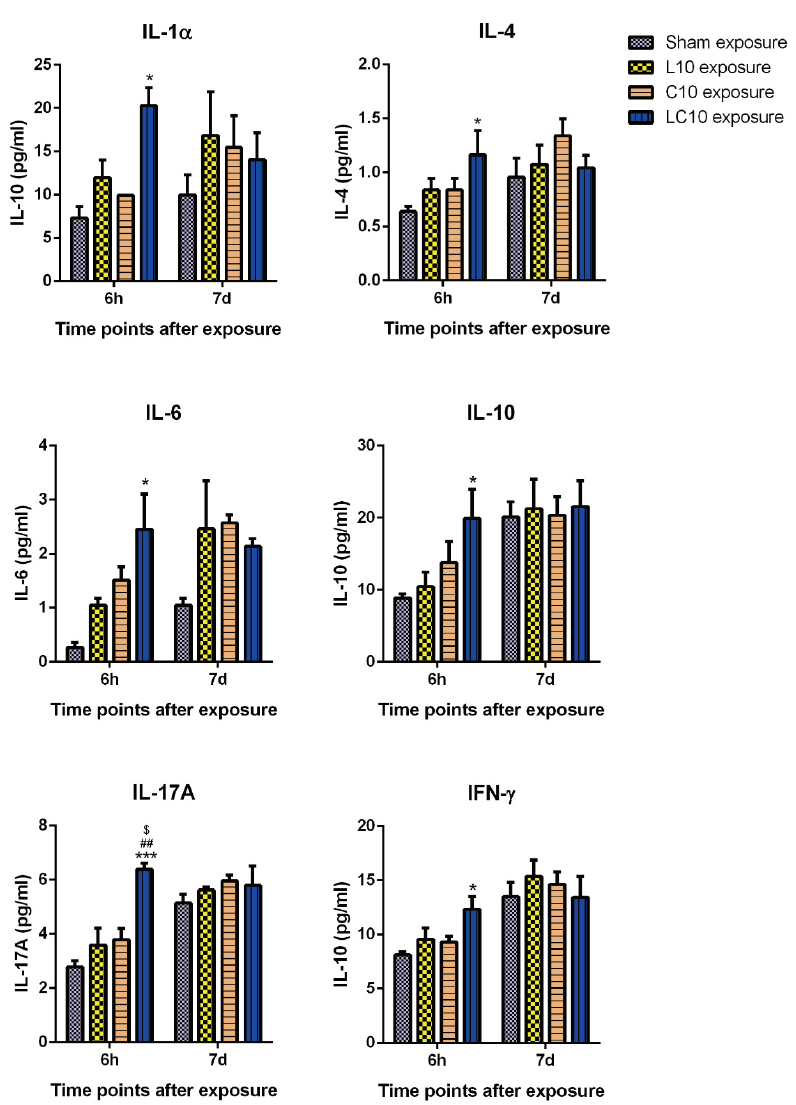
Figure 3. Compound microwaves increased cytokines expression in peripheral blood. At 6 h and 7 d after microwave exposure, the rats in the sham (Sham) group, L band (L10) group, C band (C10) group and compound bands (LC10) group were anaesthetized and the peripheral blood was collected from IVC. The serum was separated from peripheral blood by centrifugation. Then, the level of various cytokines, including interleukin (IL)-1 α , IL-4, IL-6, IL-10, IL-17A and interferon γ (IFN- γ ), was detected by flow cytometry using Cytokine&Chemokine 22-Plex Rat ProcartaPlex TM Panel. Data were shown as mean ± s.e.m. *, p < 0.05, ***, p < 0.001 vs. Sham group; ##, p < 0.01 vs. L10 group; $, p < 0.05 vs. C10 group.